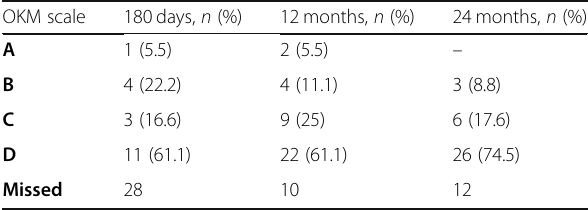
Table 4 Angiographic (DSA) follow-up over time